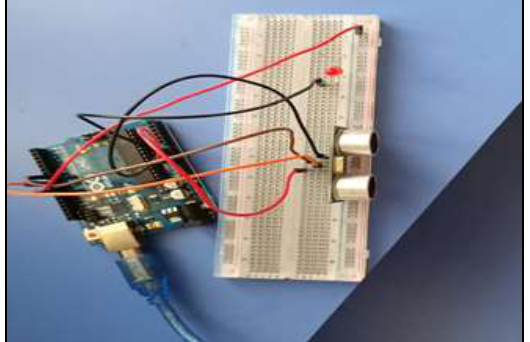
Fig. 7. Ultrasonic Sensor Reaction